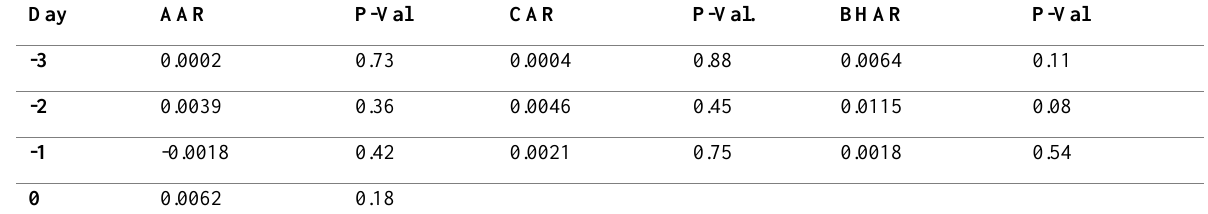
Table 1: The Effect of Positive Earnings Announcement on Stocks (on and before the